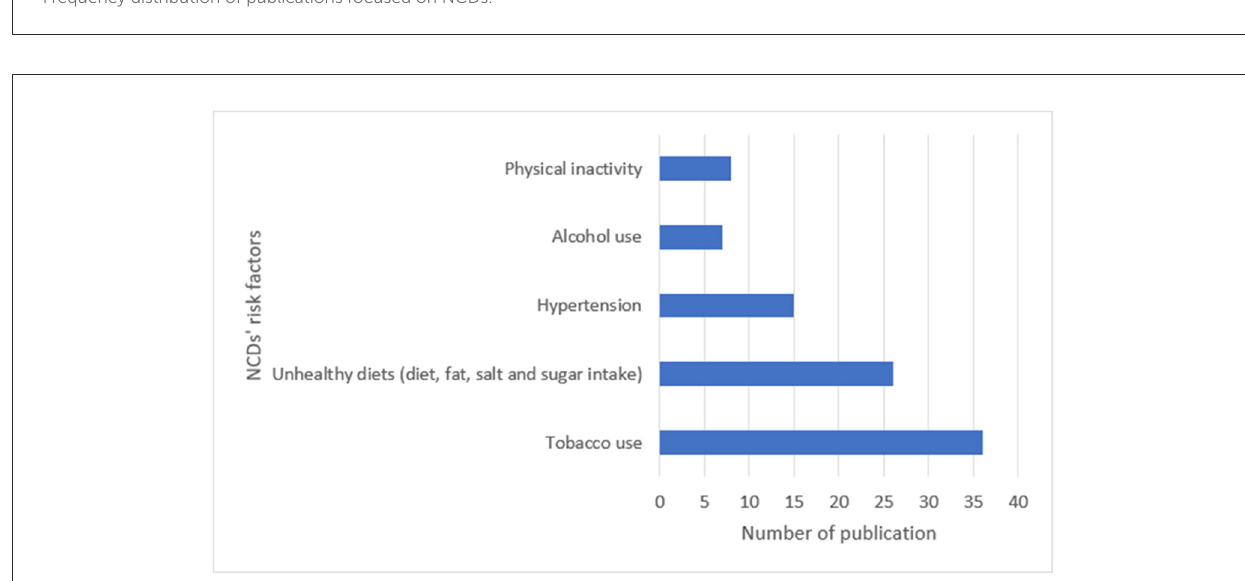
FIGURE5 Frequency distribution of publications focused on risk